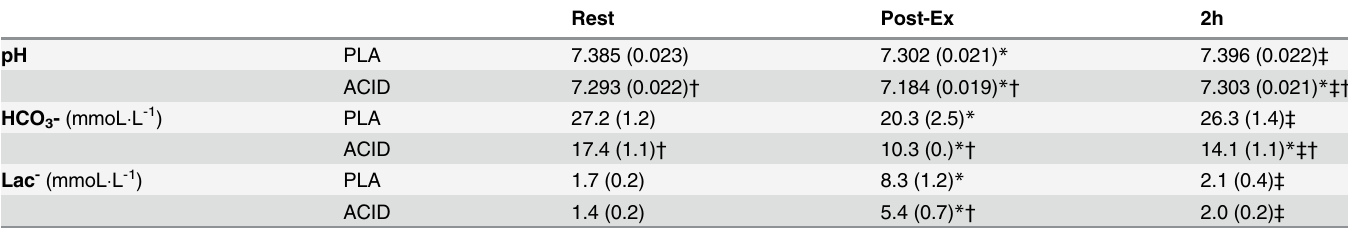
* Denotes signi fi cant difference from Rest value within the treatment ( p < 0.05). ‡ Denotes signi fi cant difference from Post-Ex value within the treatment ( p < 0.05). † Denotes signi fi cant difference to PLA value within the time ( p <